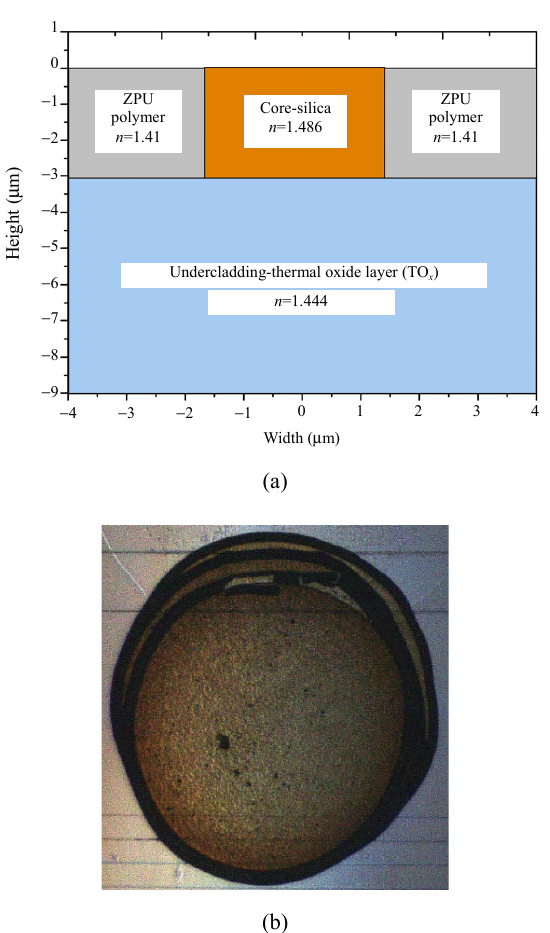
Fig. 3 Proposed device as a humidity sensor: (a) cross section of the proposed device before coating with SnO 2 nanoparticle and (b) photo of drop coated SnO 2 in the top of optical channel